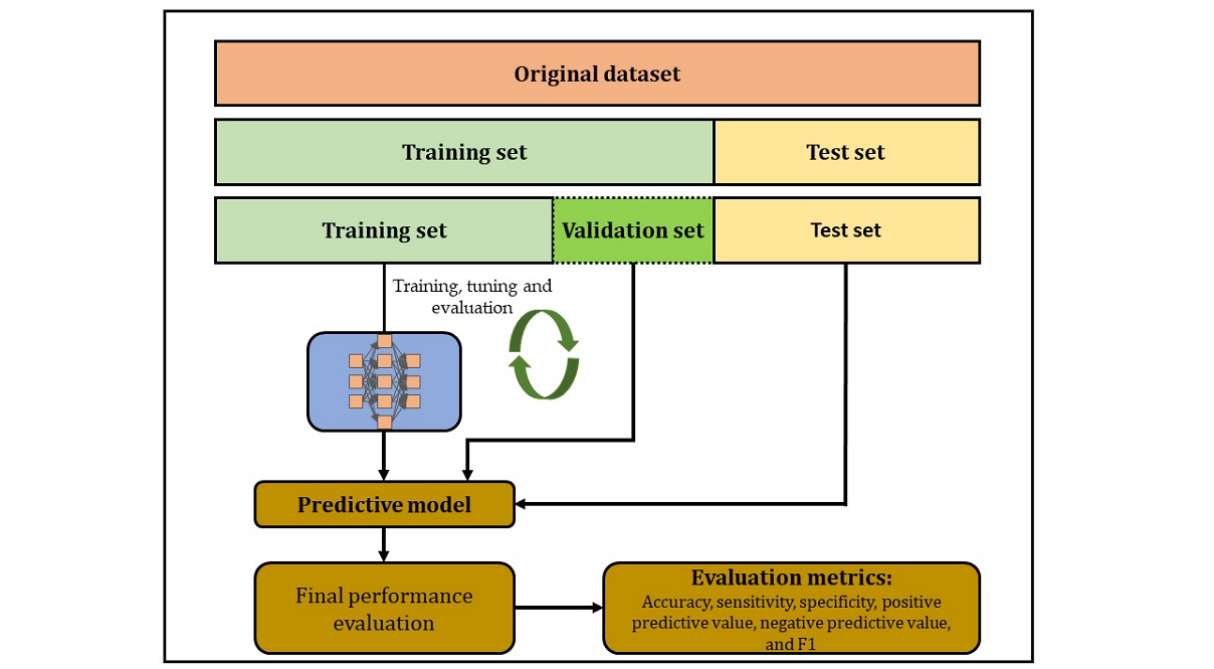
Figure 2. Distribution of training and testing datasets for model